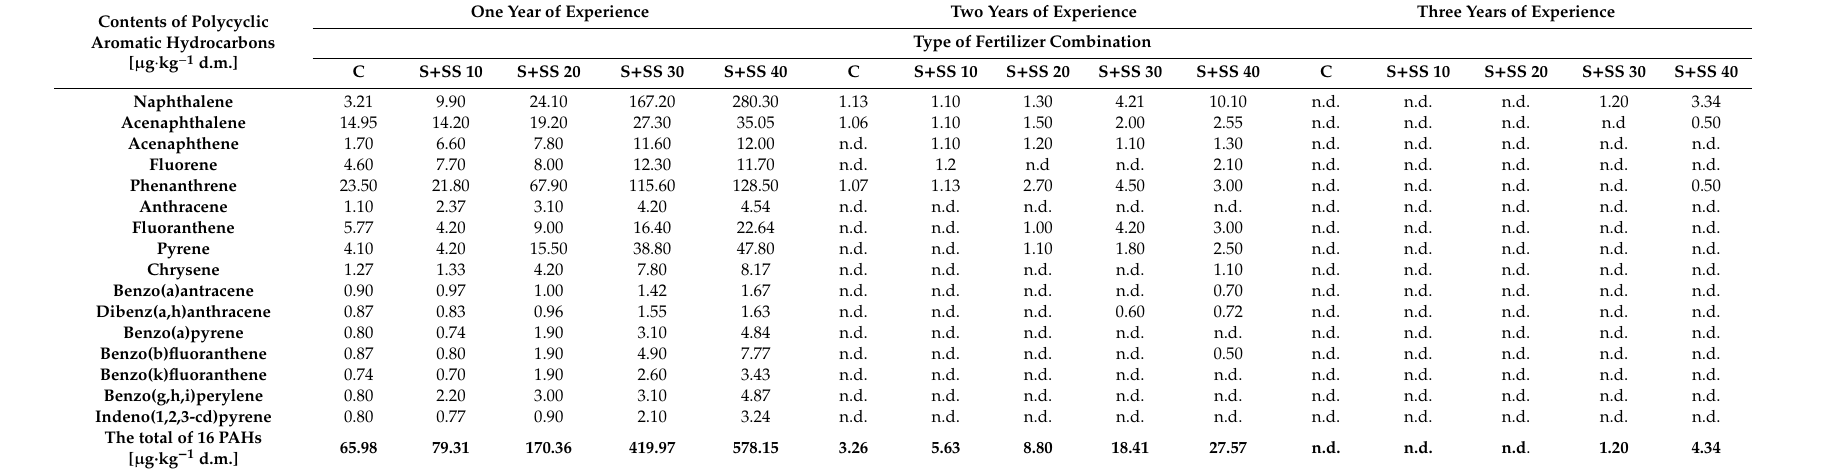
Table 5. Content of PAH in biomass from D. glomerata from soil mixtures with sewage sludge [ µ g / kg